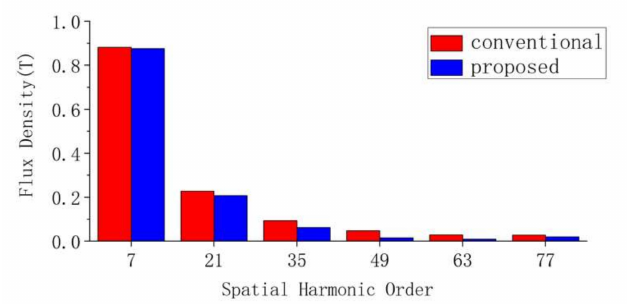
Figure 13. Comparison of flux density harmonics of a permanent magnet.